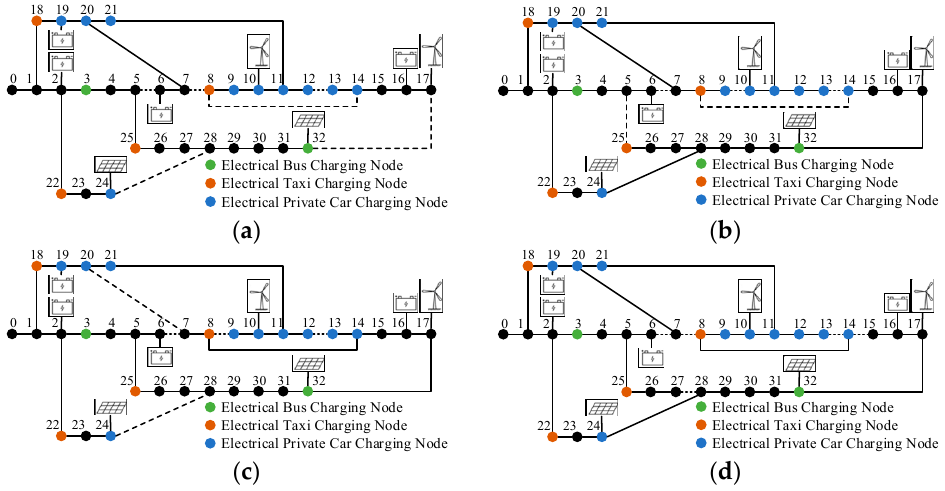
Figure 9. Optimized grid structure for each scenario. ( a ) Spring. ( b ) Summer. ( c ) Autumn. ( d ) Winter.